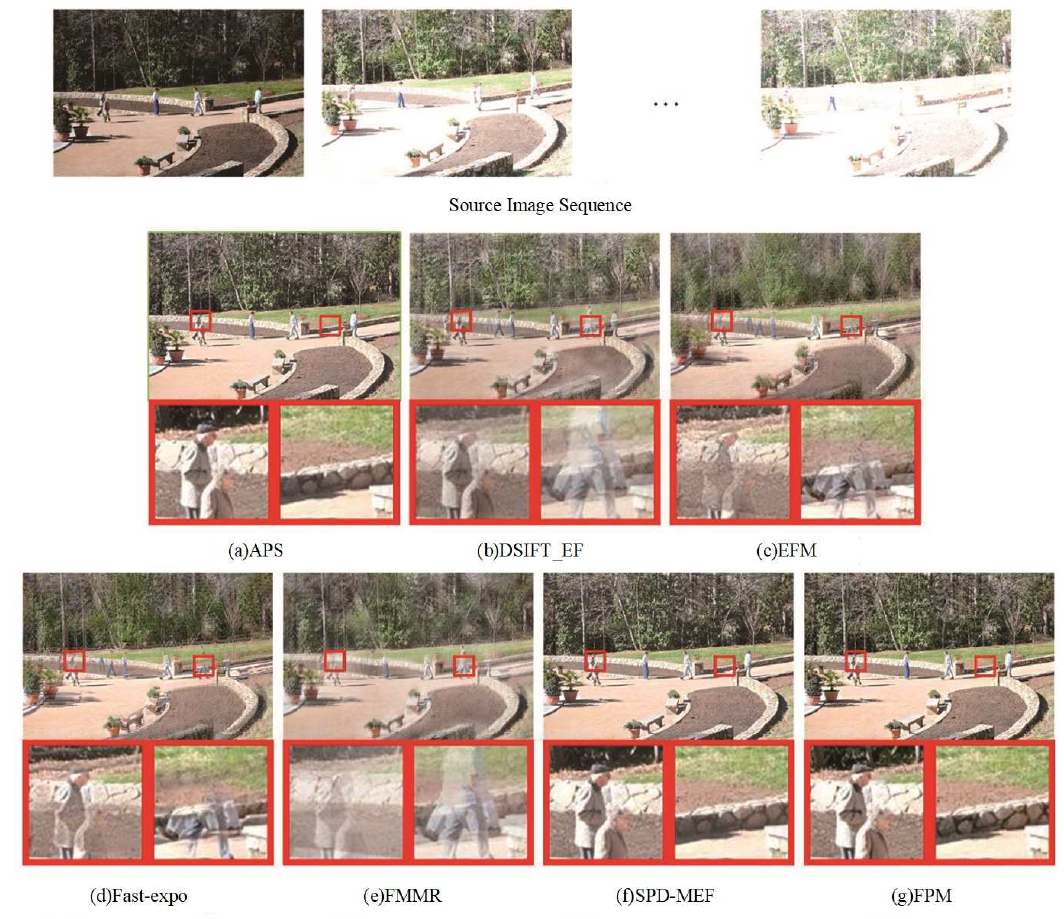
Figure 7. Comparison of the “Garden” fusion images obtained by the seven fusion methods. ( a ) APS, ( b ) DSIFT-EF, ( c ) EFM, ( d ) Fast-expo, ( e ) FMMR, ( f ) SPD-MEF, ( g )